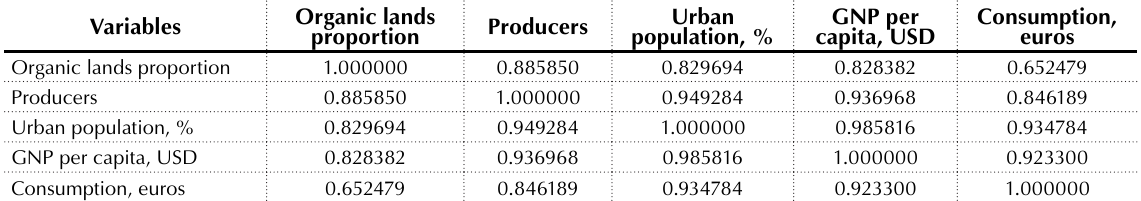
Table 3. Correlations between indicators selected